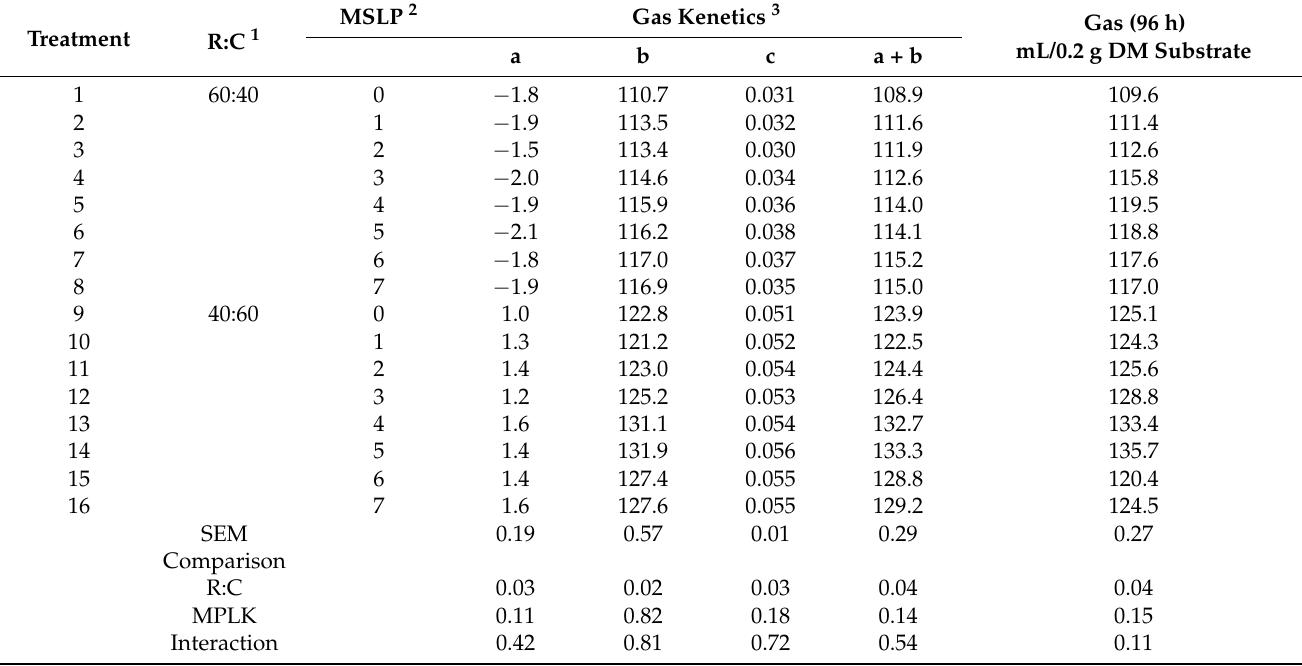
Table 2. The effect of roughage-to-concentrate (R:C) ratio with Mitragyna speciosa Korth leaves powder (MSLP) supplementation on gas kinetics and cumulative gas